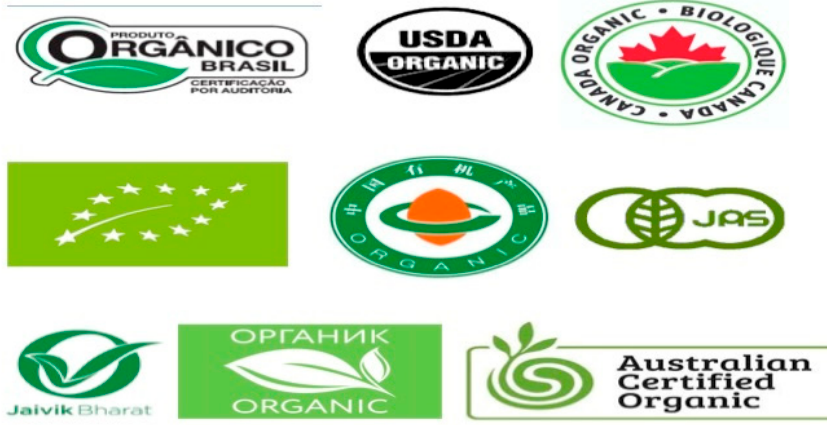
Figure 1. Organic logos/seals in force in (from left to right and from top to bottom) Brazil, USA, Canada, European Union, China, Japan, India, Russia, Australia.